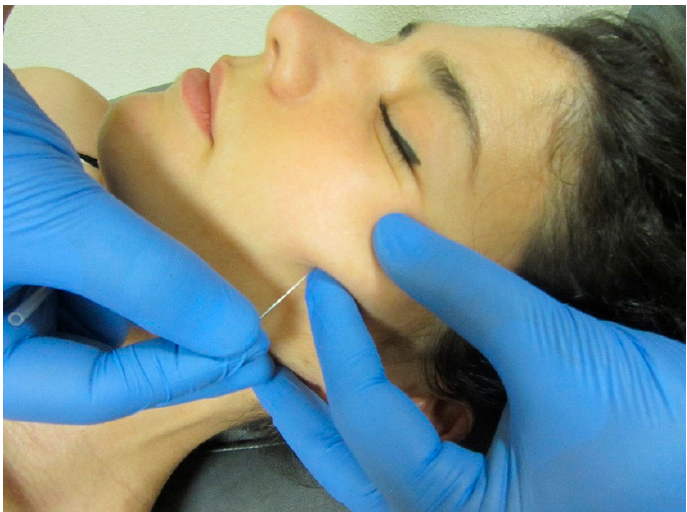
Figure 6. Dry needling of the zygomatic muscle (pincer palpation). Copyright Handspring Publishing Limited 2018. Reproduced with permission. Illustrations first published in Temporomandibular Disorders edited by César Fernández-de-las-Peñas and Juan Mesa-Jiménez, Handspring Publishing Limited, 2018.